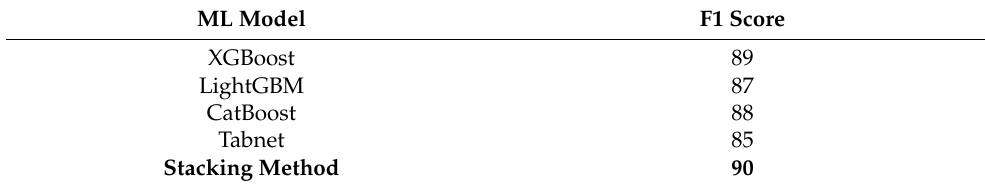
Table A4. Table of F1 score for each ML